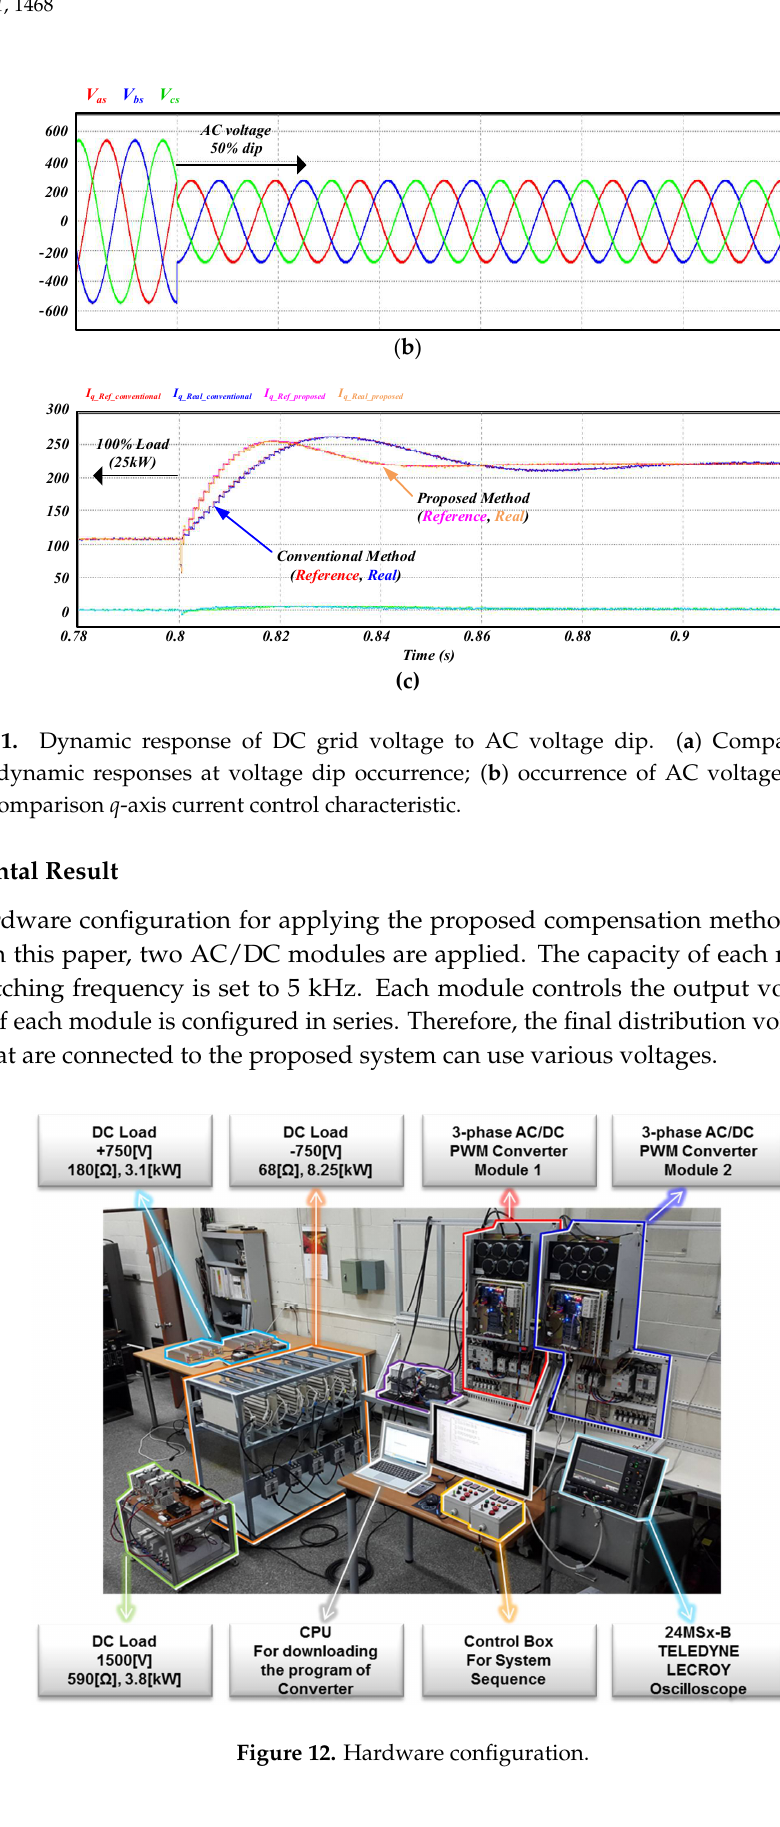
( b ) Figure 10. V dc and q -axis response characteristic (expanded). ( a ) Comparison of DC voltage dynamic responses at load connection; and ( b ) comparison q -axis current control characteristic. V dc_reference V dc_conventional V dc_proposed 755 750